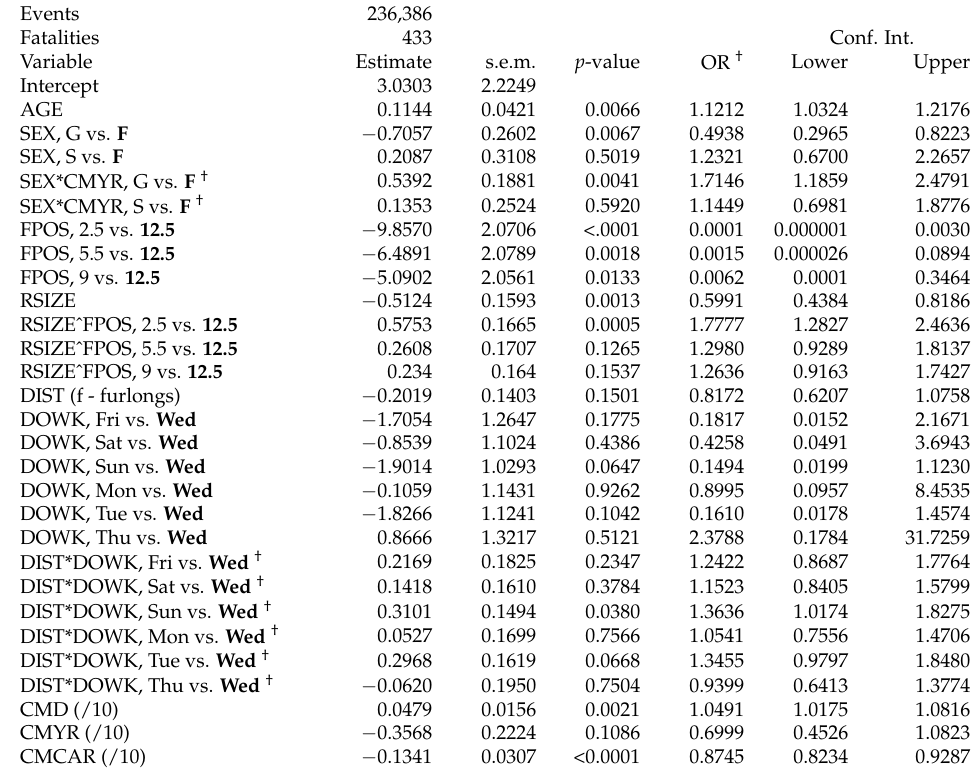
Table 4. Logistic Regression Modelling of Associations with Equine Fatality in Ontario Racing for Thoroughbred Race Events, by Event,